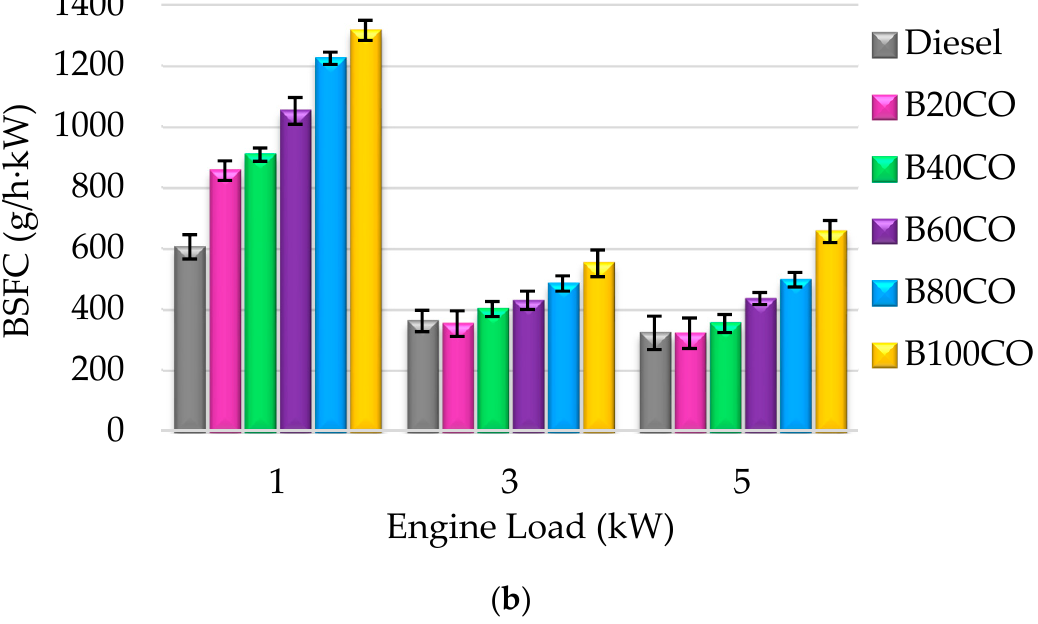
Figure 3. BSFC (g / h · kW) at low, medium and high engine loads (1, 3, 5 kW) for the fuel blends: Figure 3. BSFC (g/h·kW) at low, medium and high engine loads (1, 3, 5 kW) for the fuel blends: ( a ) ( a ) DEC / SO and D / DEC / SO; ( b ) DEC / CO and D / DEC / CO. The measure errors are represented as DEC/SO and D/DEC/SO; ( b ) DEC/CO and D/DEC/CO. The measure errors are represented as standard deviation using error standard deviation using error bars.